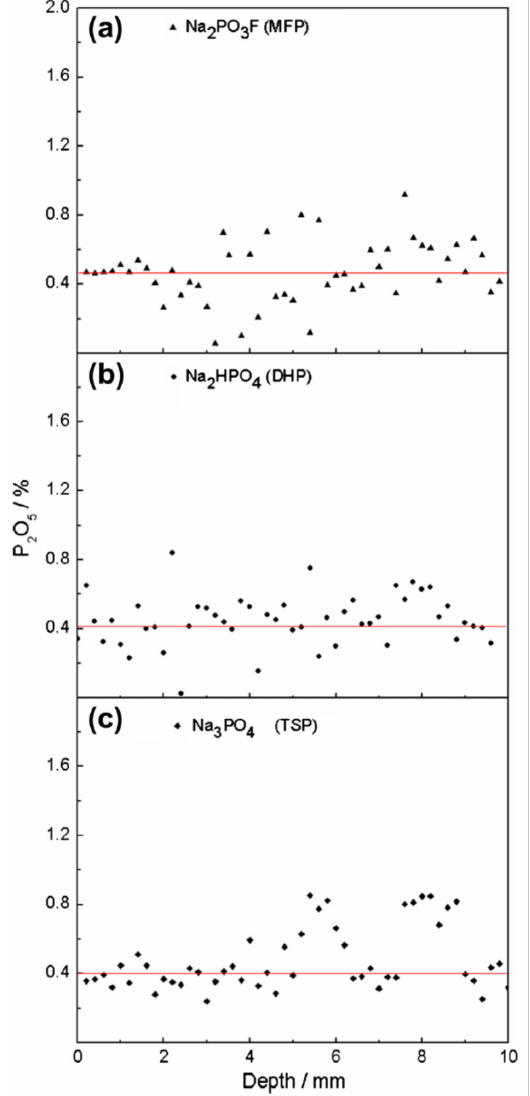
Figure 11. Content of P 2 O 5 versus penetration depth in the presence of admixture corrosion inhibitor (ACI): ( a ) MFP, ( b ) DHP and ( c ) TSP [43]. Reproduced with permission from Bastidas, D.M. et al., Cem. Conc. Comp.; published by Elsevier, 2013. The six mortar specimens in 5 wt.% TSP, 5 wt.% DHP or 5 wt.% MFP aqueous